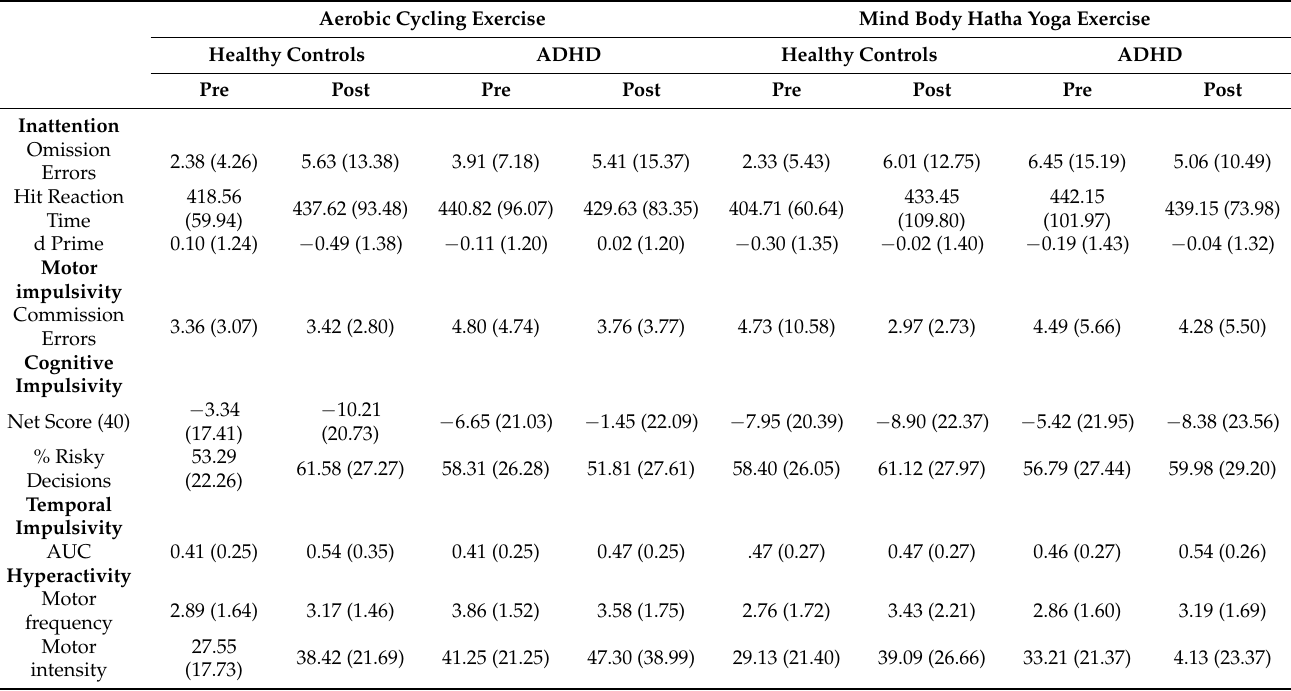
Table 2. Descriptive statistics for Healthy Controls and those with ADHD, before and after cycling and yoga. All scores expressed as M ±